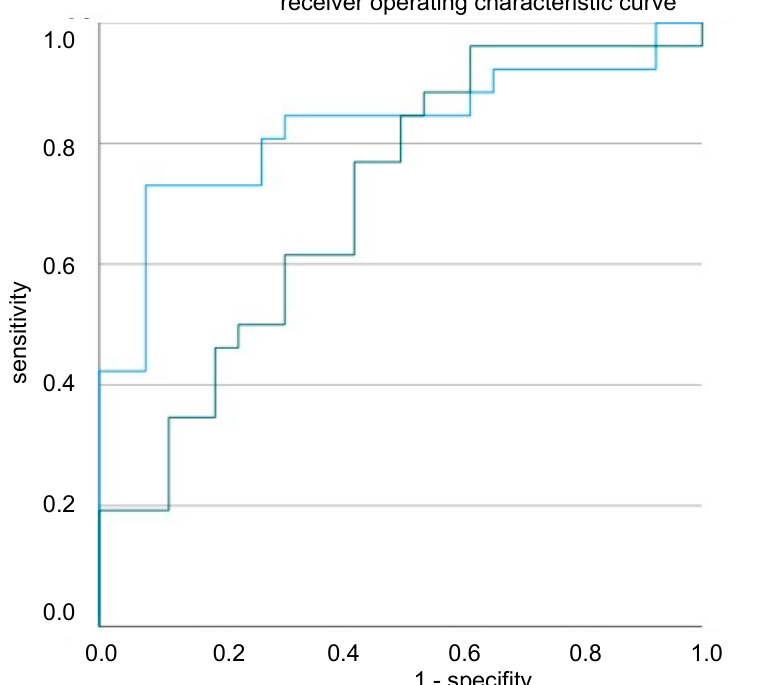
Figure 3. Receiver operating characteristic curve (ROC) analysis revealed a good performance of our prediction model for R2 habituation at an interstimulus interval of 3–5 s (R2h_3–5 s 0.82) and R2 amplitude at an interstimulus interval of 8–10 s (R2a_8–10 s 0.76).